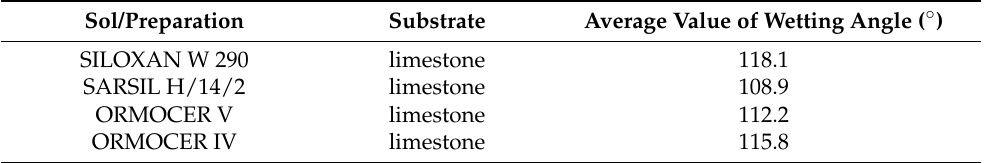
Table 2. Wetting angle values of limestone.